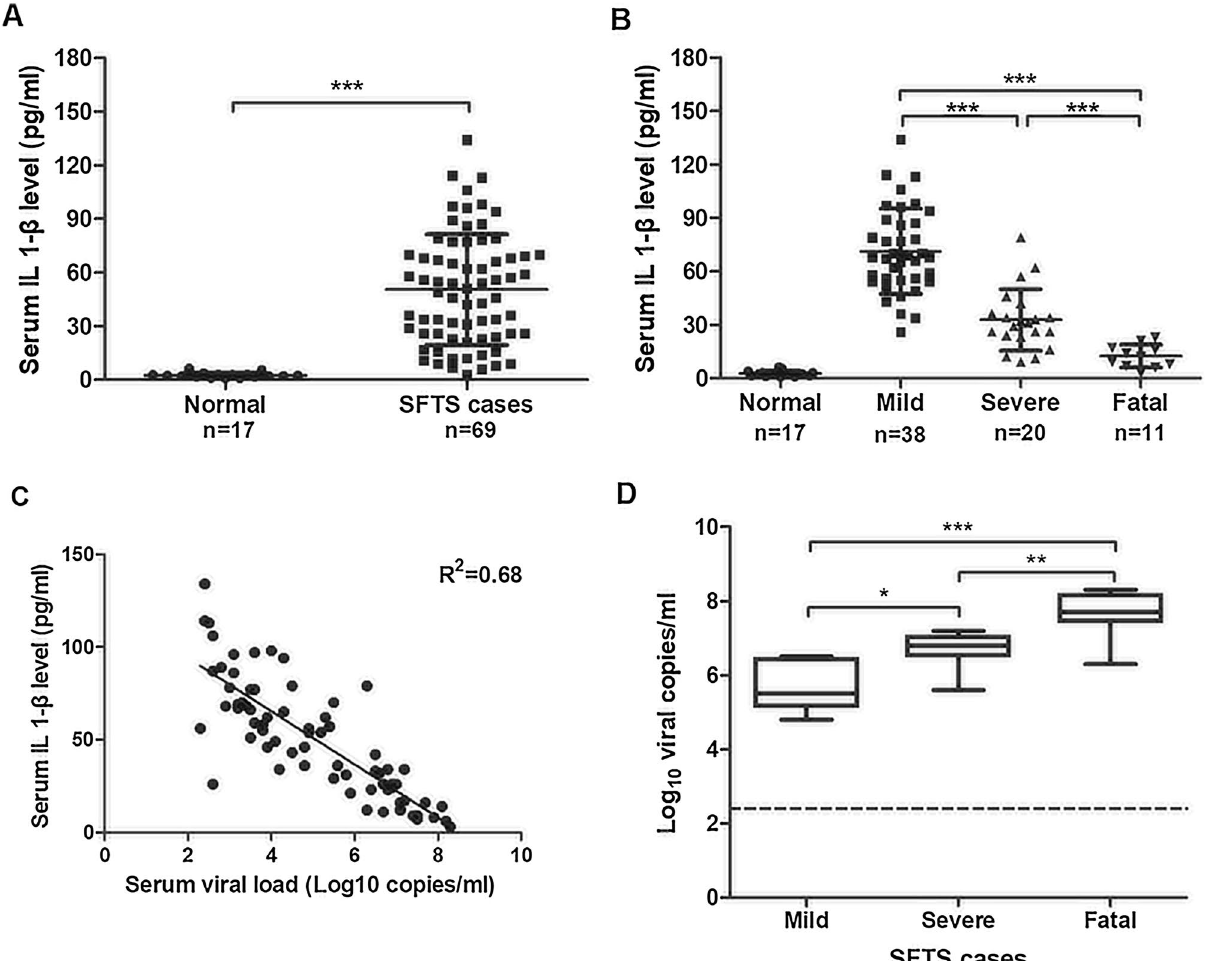
Figure 1. Elevated IL-1β secretion in blood of the SFTS patients. ( A ) Increased IL-1β levels in the sera of patients (n = 69) and healthy individuals (n = 17) was determined by ELISA. Data shown were means ± SEM; *** P < 0.001 (two-tailed Student’s t-test). ( B ) IL-1β levels in the sera of the SFTS patients were negatively correlated to disease severity clinically. ( C ) Negative correlation was between the IL-1β levels and viral